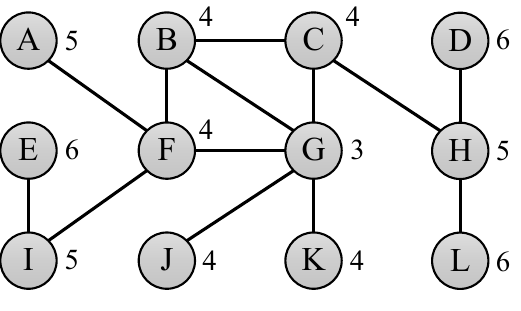
Figure 2. Toy graph showing the eccentricity of its 12 nodes, with average eccentricity 4.67, radius 3 realized by center node G, and diameter 6 realized by periphery nodes D, E and L.